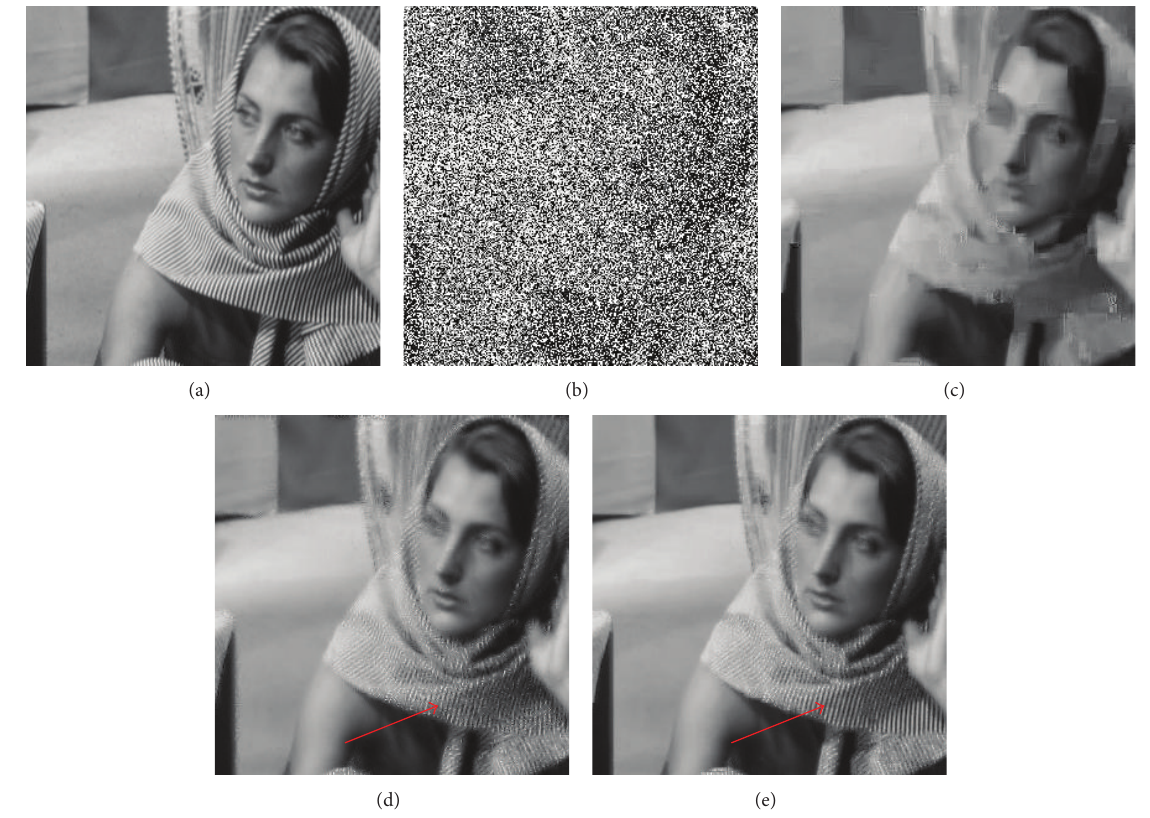
Figure 12: Denoising results of Barbara image with 70% salt-and-pepper noise. (a) Ground truth image, (b) noisy image, and (c), (d), and (e) are denoised images using the proposed method, total variation with noise detectors, and the proposed method with noise detectors,